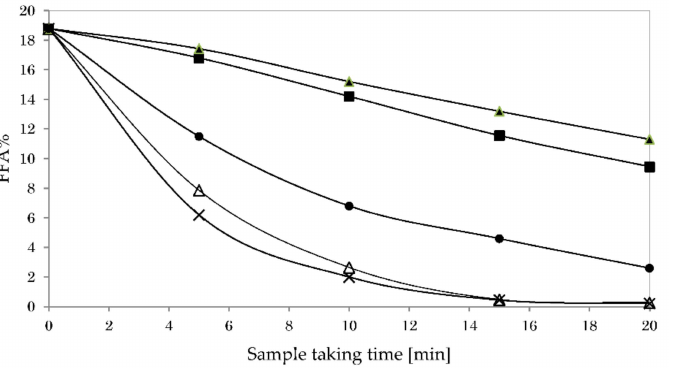
Figure 13. Impact of the operating temperature on glycerolysis reaction ( (cid:78) : 120 ◦ C, (cid:4) : 150 ◦ C, • : 180 ◦ C, ∆ : 200 ◦ C, × : 250 ◦ C), (Stirring speed: 350 rpm, Time: 30 min, Catalyst: 1 wt.% KOH, Co-solvent: 0.5 wt.% hexane, Oil-to-glycerol molar ratio: 1:4).